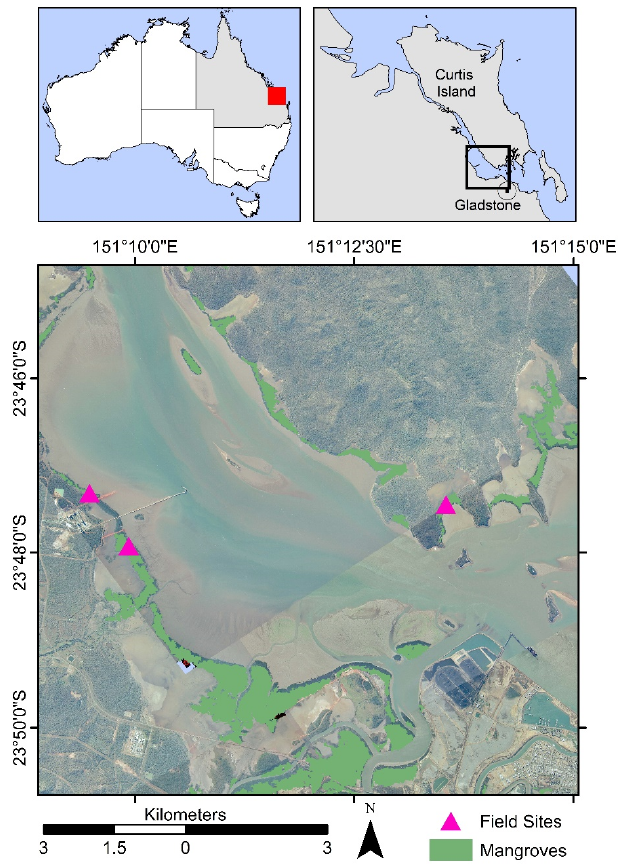
Figure 2. Location of the field sites and mangrove patches in the Gladstone region, Queensland. Aerial